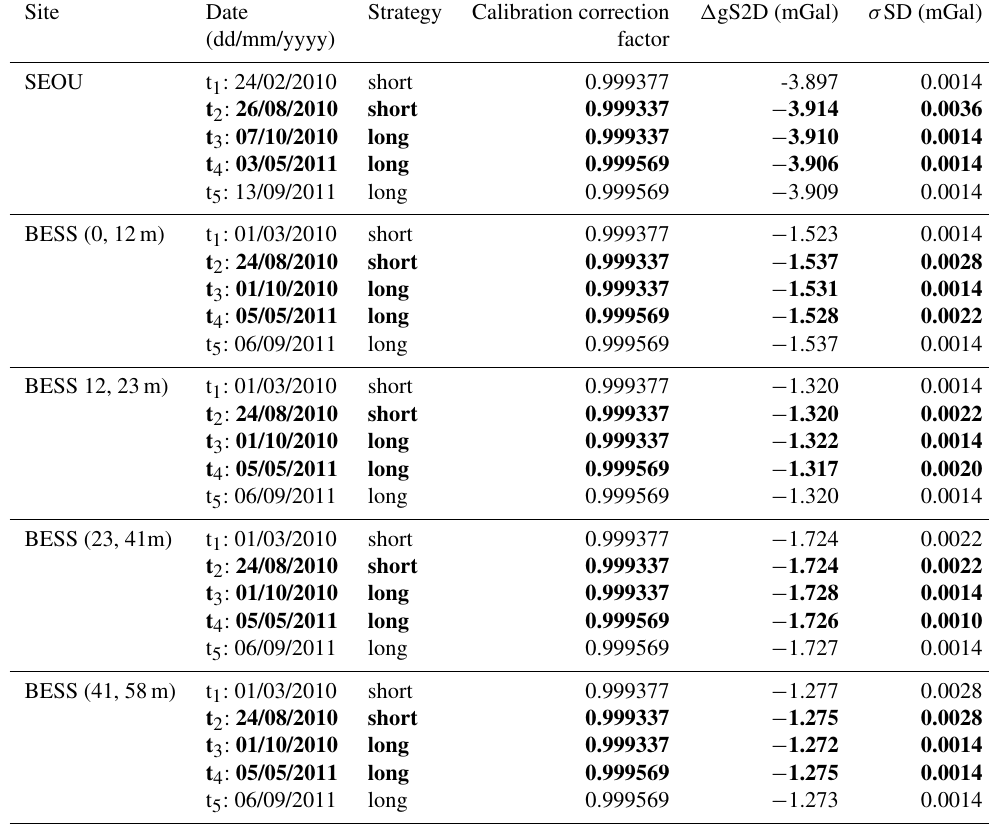
Table A1. Results of the least-square inversion for each site and each time period. Results at the BESS site are represented for each thickness. Strategy stands for the number of gravity measurements at the reference gravity points depending on the strategy (long or short). Recharge periods are indicated by the bold